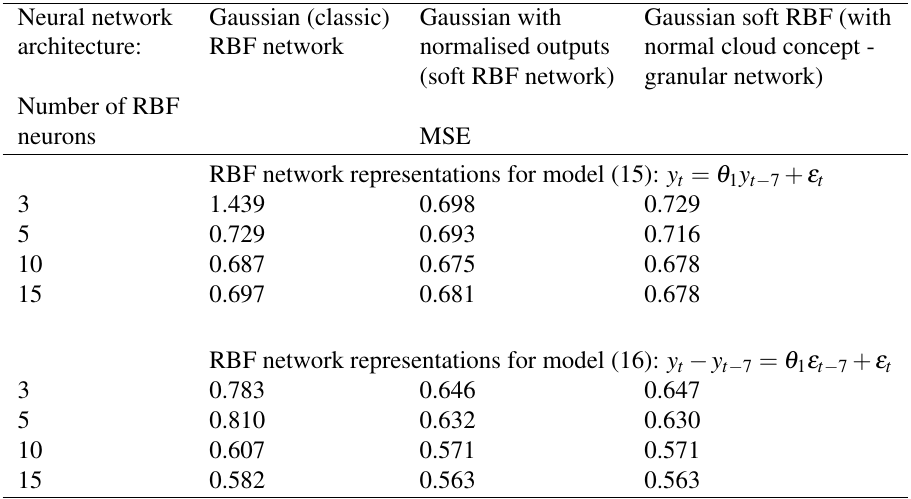
Table 4. Approximation results of various RBF‘s networks re- lated to the different number of clusters (RBF